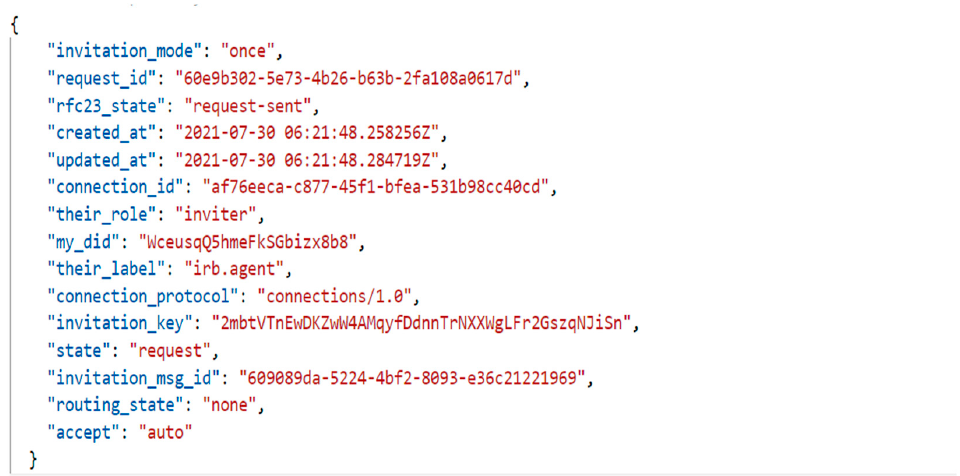
Figure 11. JSON format of the accepted message associated with the invitation.